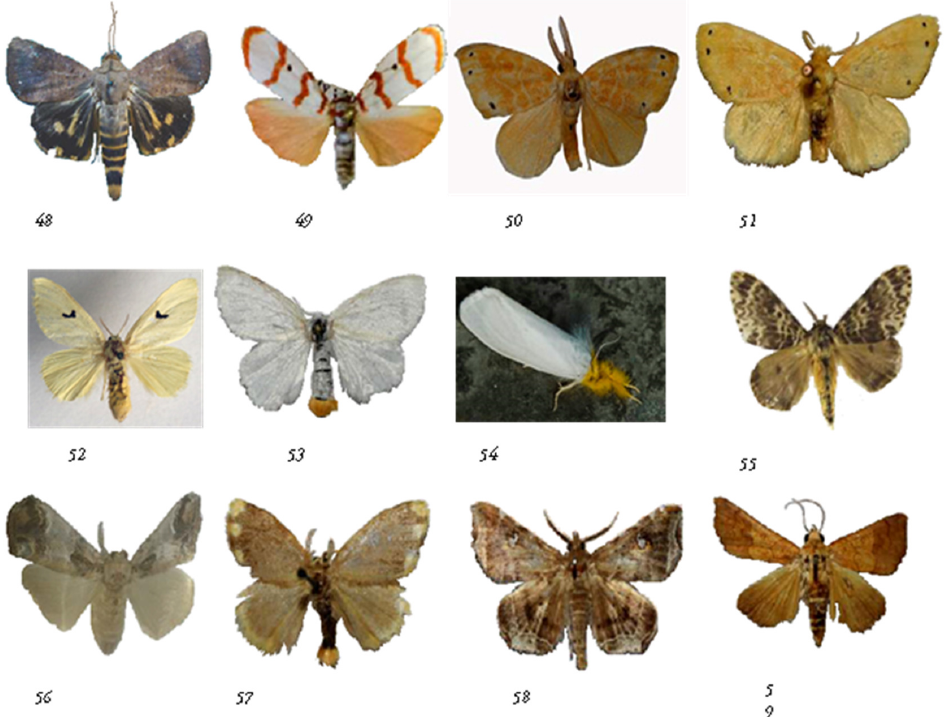
Plate 5. 48- Hypocala violacea; 49- Cyana puella; 50- Artaxa digramma; 51- Euproctis fraterna; 52- E. lunata; 53- E. similis ; 54- Laelia exclamationis ; 55- Lymantria mathura ; 56- Olene mendosa; 57- Orvasca subnotata; 58- Episparis liturata; 59- Anomis